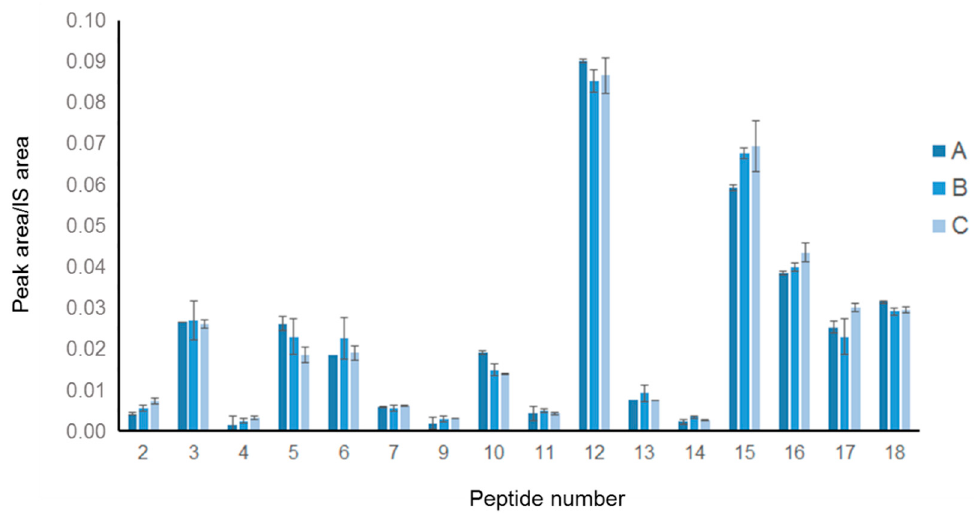
Figure 3. Quantitative analysis of the marker peptides in the LC-MS/MS analysis of three different Spirulina samples (A, B, C). Measurements were performed in triplicate on two different samples of each powder ( n = 6): the graphs report the average areas and standard deviations. No significant differences between the abundance of peptides from the three samples were observed.